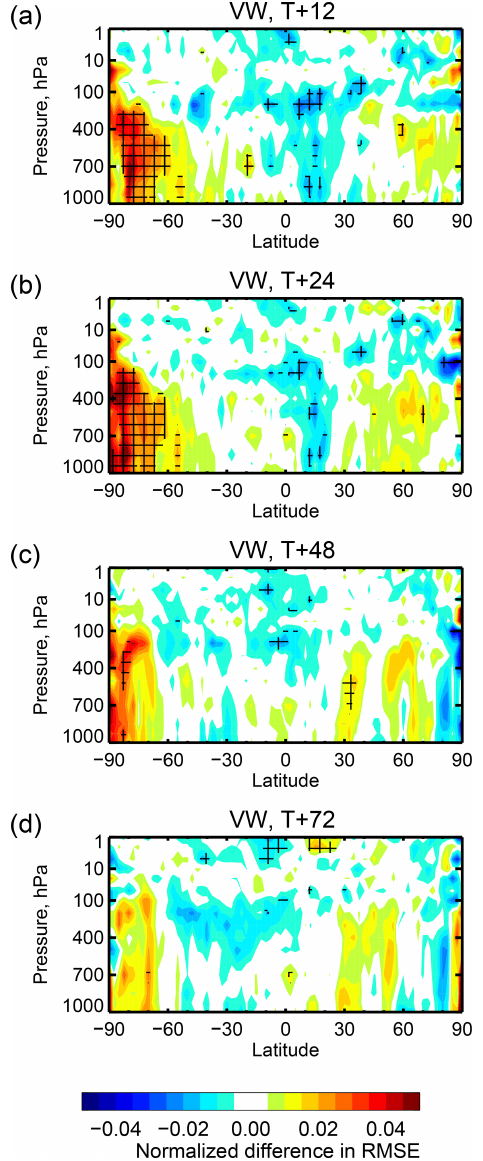
Figure 19. Difference in vector wind RMSE between using the all- sky and clear-sky approach to assimilate seven IASI WV channels. Other details are the same as in Fig. 17.